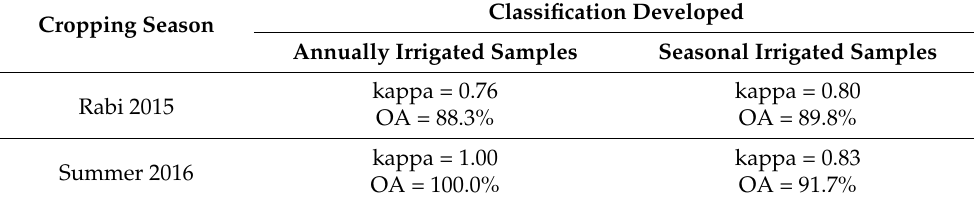
Table 5. Validation of the method